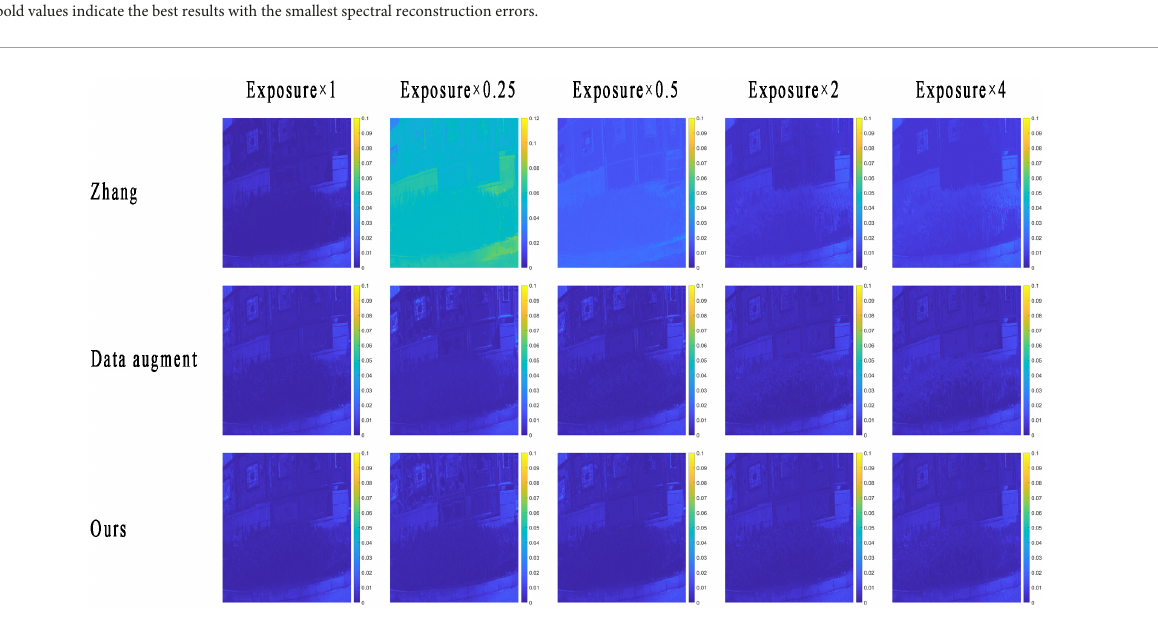
FIGURE7 The root-mean-square error (RMSE) map of the reconstructed multispectral image (RMSI) of the original and proposed under different tested exposure levels. The photos appearing in these figures are chosen from the public multispectral dataset from the NTIRE challenges (https://icvl.cs.bgu.ac.il/projects/ntire2020/).